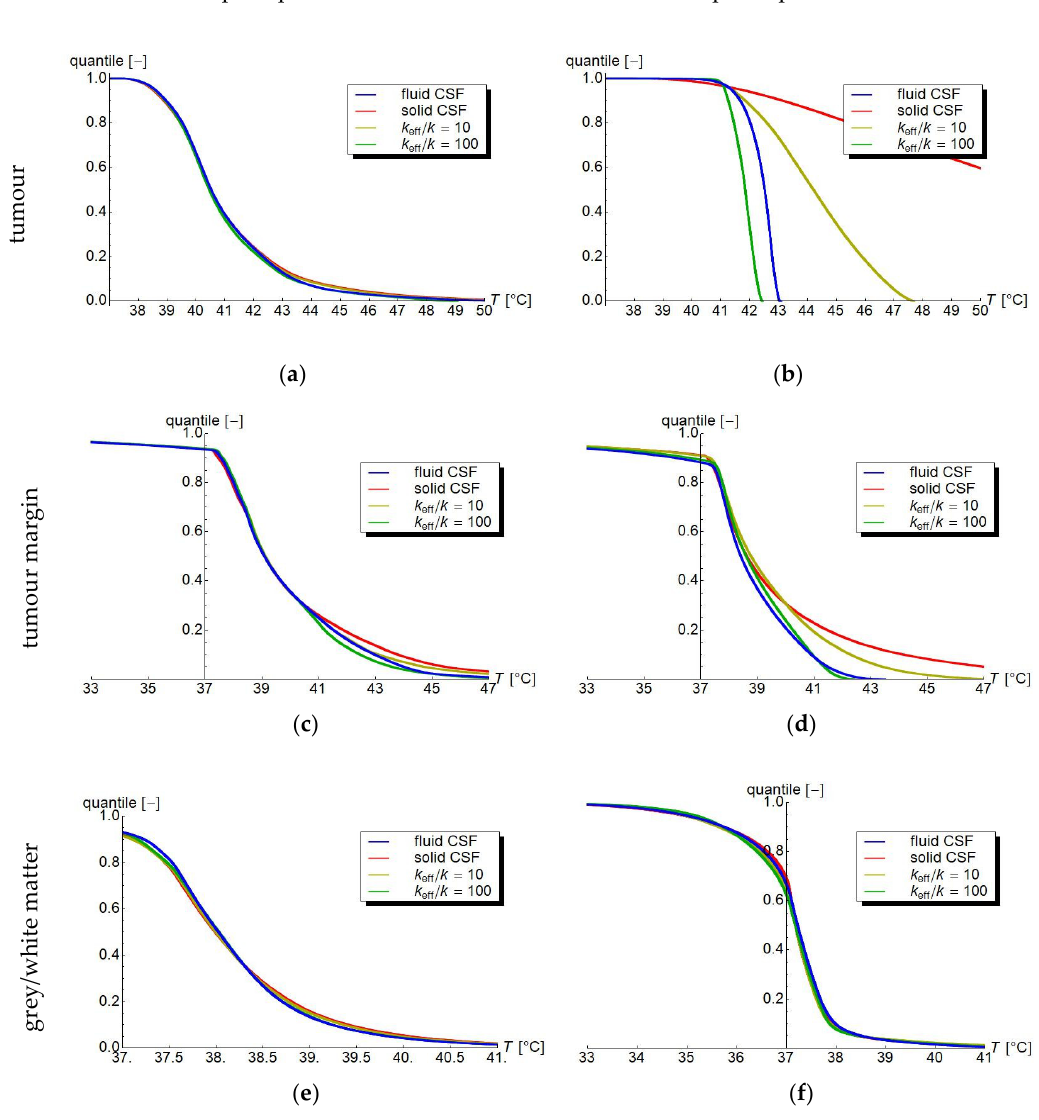
Figure 6. Temperature volume histograms showing volume quantile versus temperature for ( a,b ) the tumour (region), ( c,d ) the tumour margin (tumour margin), and ( e,f ) the grey / and white matter. ( a,c,e ) In the pre-operative case, these temperature volume histograms are fairly similar for the fluid, solid, and high- k models, although the solid and high- k models tend to overestimate high temperature volumes. ( b , d,f ) Post-operatively, the situation is similar for the white and grey matter, and more pronounced for the tumour margin. For the CSF-filled volume where the tumour has been excised, the differences are much larger. The fluid model reflects the efficient convective mixing leading to a relatively homogeneous temperature in the fluid volume, the solid model has no way to efficiently dispose of the generated heat and, therefore, greatly overestimates the temperature. The high- k models vary between those two, and may overestimate heat removal for large values of k eff / k , underestimating temperatures.